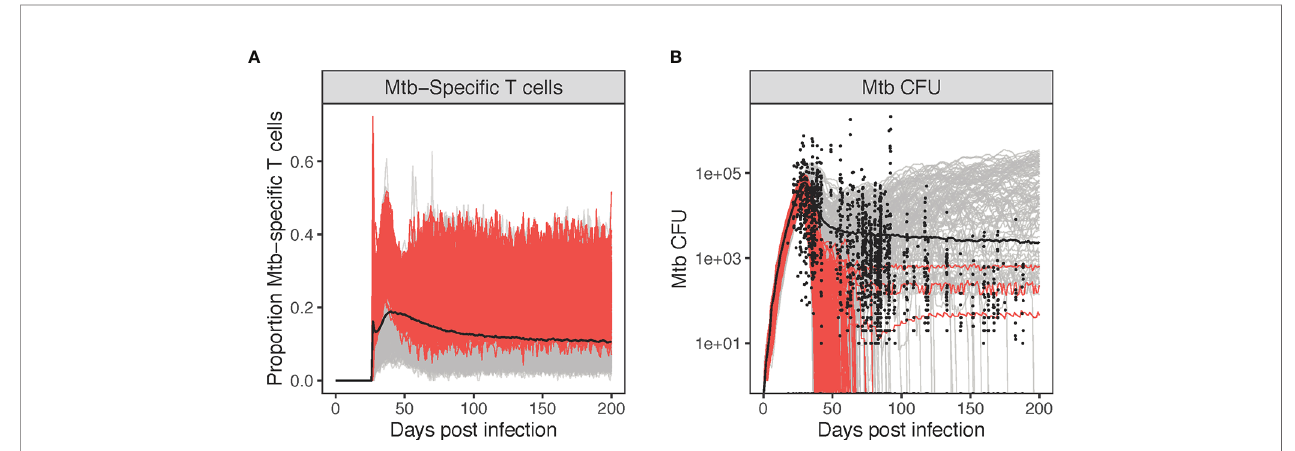
FIGURE 7 | Varying levels of Mtb-speci fi city in granuloma T cells to match non-human primate (NHP) studies. Panel (A) : The proportion of Mtb-speci fi c T cells over the course of virtual infection. Panel (B) shows the CFU [shown together with 1,994 NHP granulomas (black circles)]. Highlighted in red are simulations where the probability of Mtb-speci fi c T-cell classes recruited are allowed to exceed 10% (up to 25%). All other simulations are gray (1% –